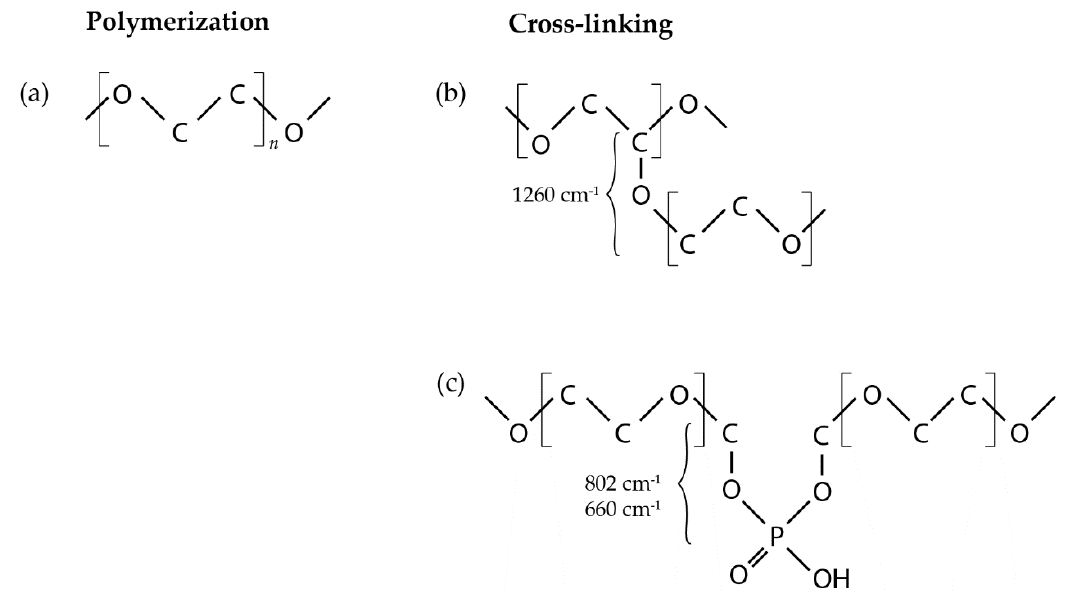
Figure 5. Hypothesis for the irradiation-induced reactions occurring in PEO hydrogels that are prevented or limited by the free radical scavenging activity of HT. ( a ) Interchain polymerization reaction suggested by the decrease in the areas of peaks of at 1241 cm − 1 , 1908 cm − 1 , and 841 cm − 1 observed in IR spectra in all irradiated buffer; ( b ) Intrachain cross-linking reaction suggested by the new peak at 1260 cm − 1 observed in IR spectra in irradiated phosphate-based hydrogels; ( c ) Cross-linking reaction between PEO chains and phosphate suggested by the new peaks at 802 cm − 1 and 660 cm − 1 observed in IR spectra in irradiated phosphate-based hydrogels.